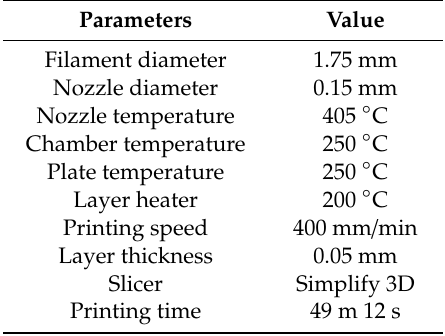
Figure 7. Dental implants printed with Orion Generation 2 (( b – d ) are × 1.2, × 1.5, and × 2 scale of a separately; ( a , b ) are printed with a 0.15 mm nozzle at the temperature of 405 ◦ C; ( c ) is printed with a 0.2 mm nozzle at a temperature of 390 ◦ C; ( d ) is printed with a 0.4 mm nozzle at a temperature of 390 ◦ C, ( e ) is the group photo of the above samples). Table 5. The parameters used for a × 1.2 scale dental implant printed with the second-generation printer of Orion.